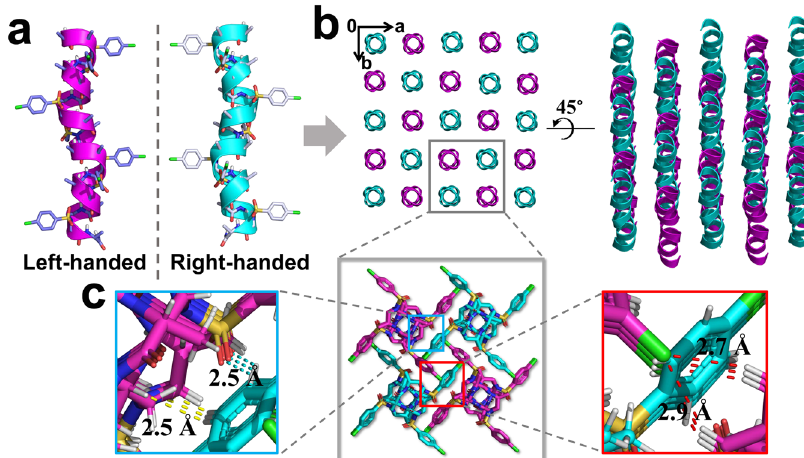
Fig. 6 Crystal structure of the heterochiral coiled-coil-like 11. a Single-crystal structures of left-handed helix D -15-mer 9 and right-handed helix L -15-mer 8 . b The crystal structures and crystal packing of heterochiral coiled-coil formed by racemic 15-mer 11 . c Representative intermolecular interactions in the racemic crystals of 11 . The intermolecular C = O···H ‒ Ph and C ‒ H···H ‒ Ph interactions are indicated as cyan and yellow dashed line, respectively. The interhelical C ‒ H···Cl ‒ Ph interactions are shown as red dashed line. Solvent molecules were excluded from the crystal